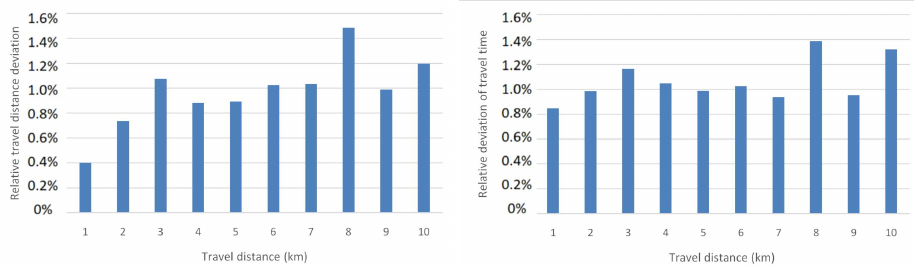
Figure 11. Comparison of simulations of bicycle travels with and without slope correction. Travel distance ( left ) and travel time ( right ) difference is minimal, even for long